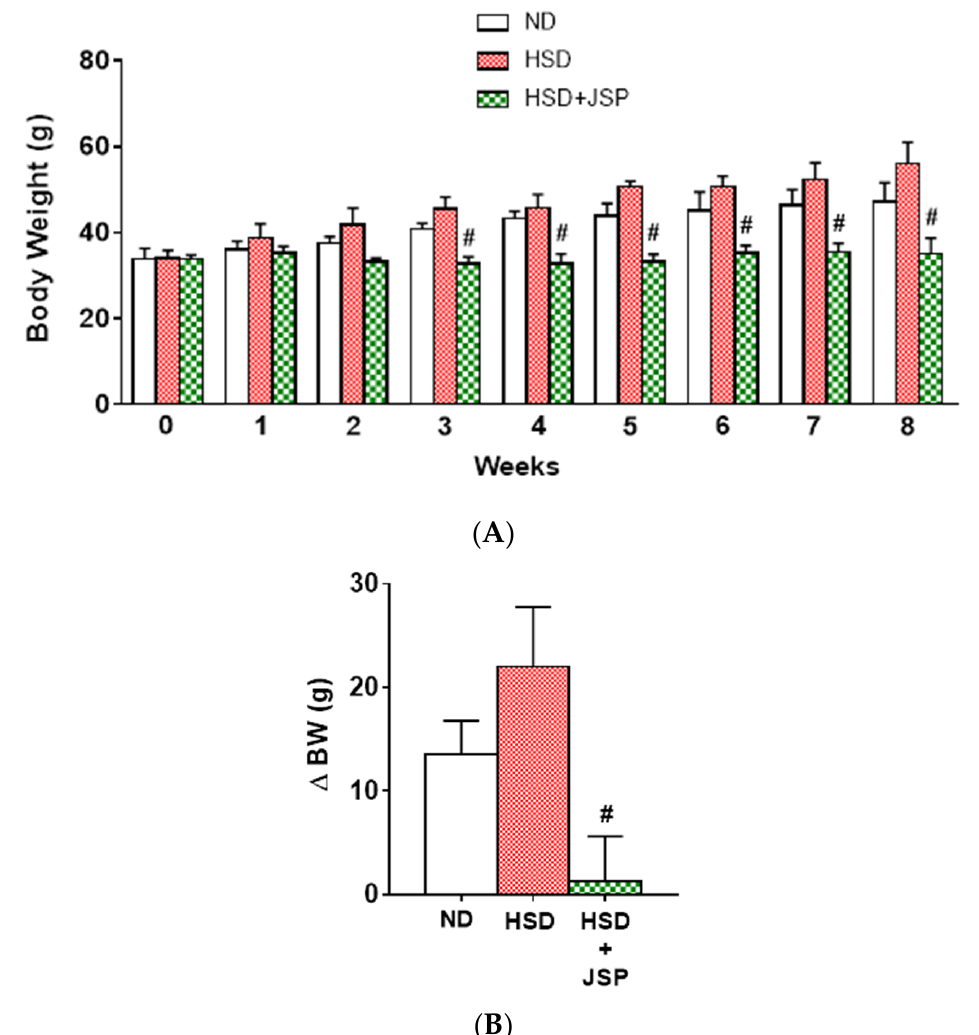
Figure 2. JSP supplementation counteracted the body weight gain in HSD-fed mice. ( A ) Body weight was monitored weekly, ( B ) Body weight gain was determined at the end of treatment. ND: Normal Diet; HSD: High-Sugar Diet; and JSP: Jackfruit Seed Powder. # p < 0.05 vs. HSD by one-way ANOVA followed by Tukey’s post hoc test. Bars represent mean ± SEM. n ≥ 3 for each group.